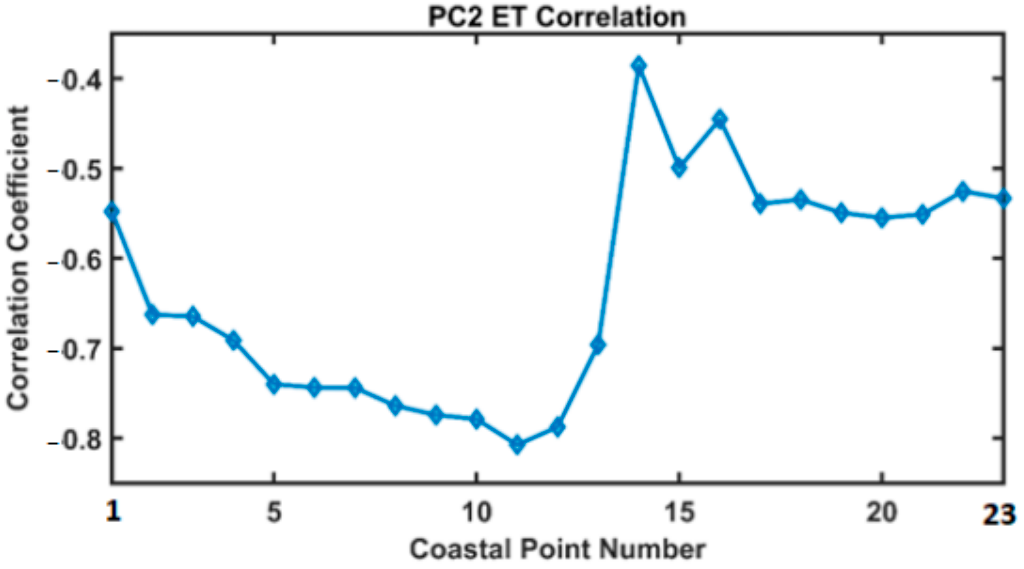
Figure 12. Correlation between the SSHA reconstructed with the first mode and local ET.